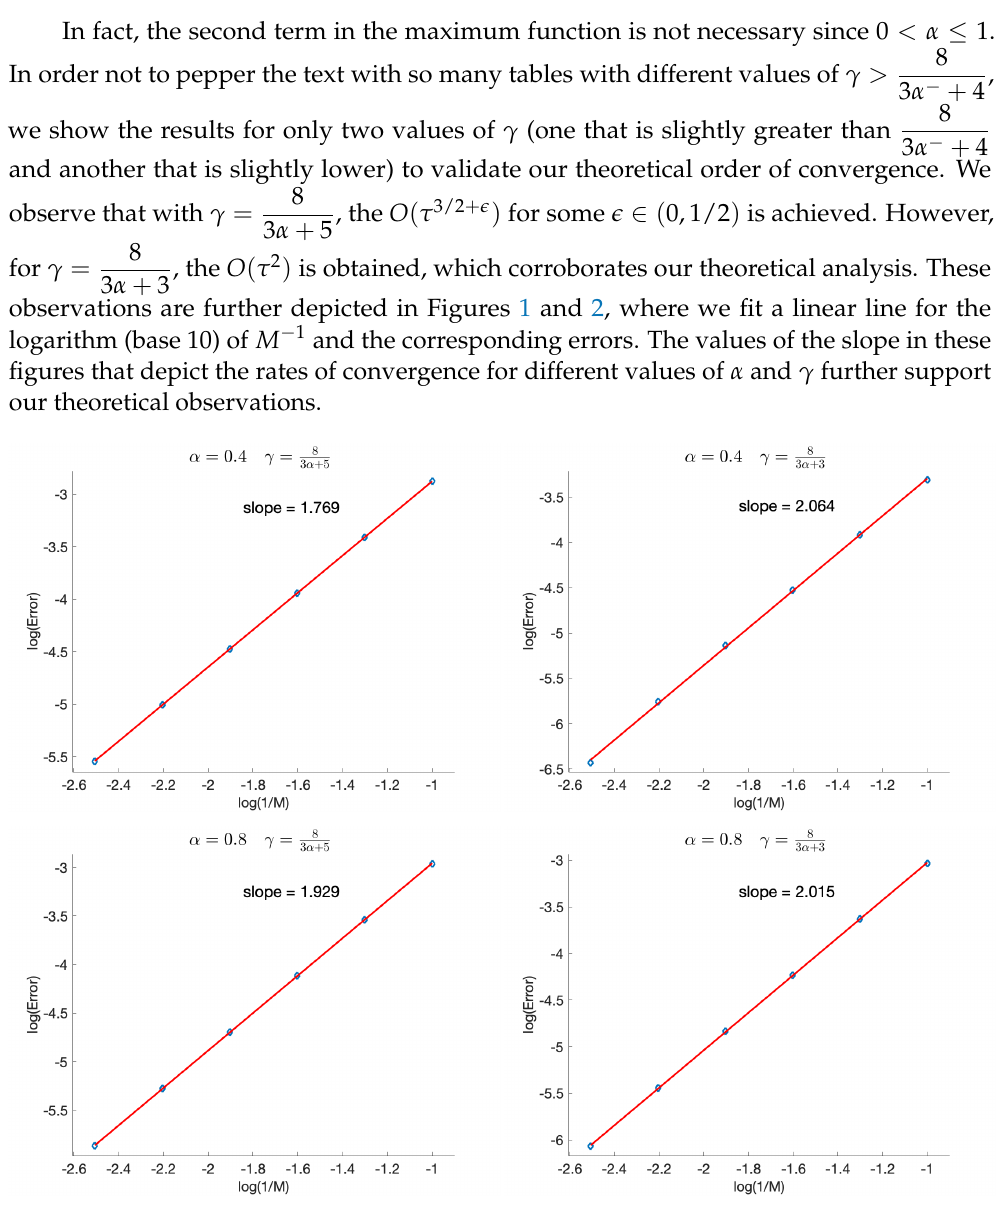
Figure 1. Log-log error plots for Example 1 with g ( u ) = 0, showing the rate of convergence of the